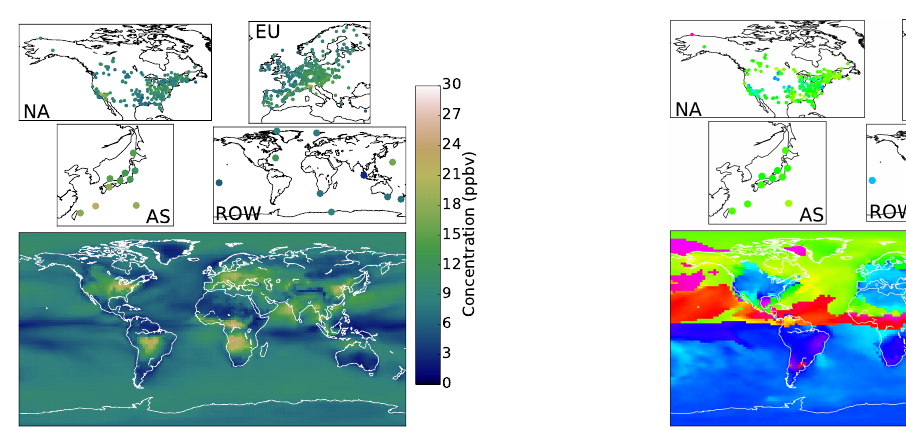
Figure 6. Seasonal amplitudes of observations (upper panels) and model (lower panel). NA is North America, EU is Europe, AS is Asia, and ROW is rest of world.